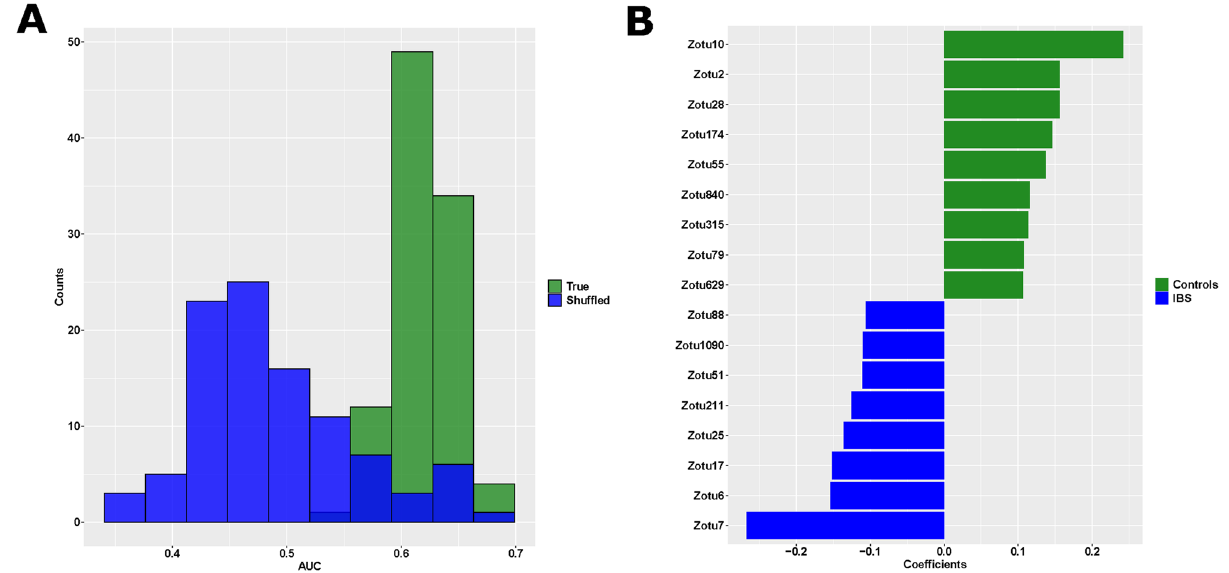
Figure 3. Predictive power of mycobiome to distinguish between IBS and controls. ( A ) Distribution of mean Area under the curve (AUC) of each tenfold cross validation, across 100 iterations, using true, and shuffled classes. The difference was significant between True (0.619 ± 0.025), and Shuffled (0.489 ± 0.071) classes (p-value < 0.001). B) Feature coefficients from trained models, significantly different from random are shown. zOTUs with negative coefficients are associated with IBS, and those with positive coefficients are associated with controls (green).